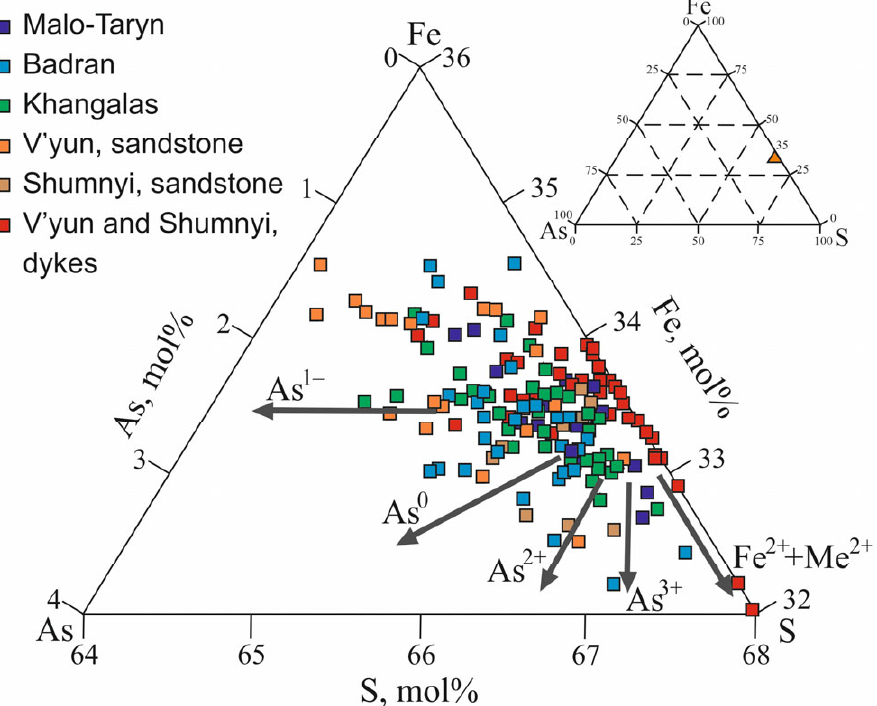
Figure 16. Ternary diagram showing the As-Fe-S composition of pyrite in the studied OGDs, central YKMB. The demarcated fields are after [104].